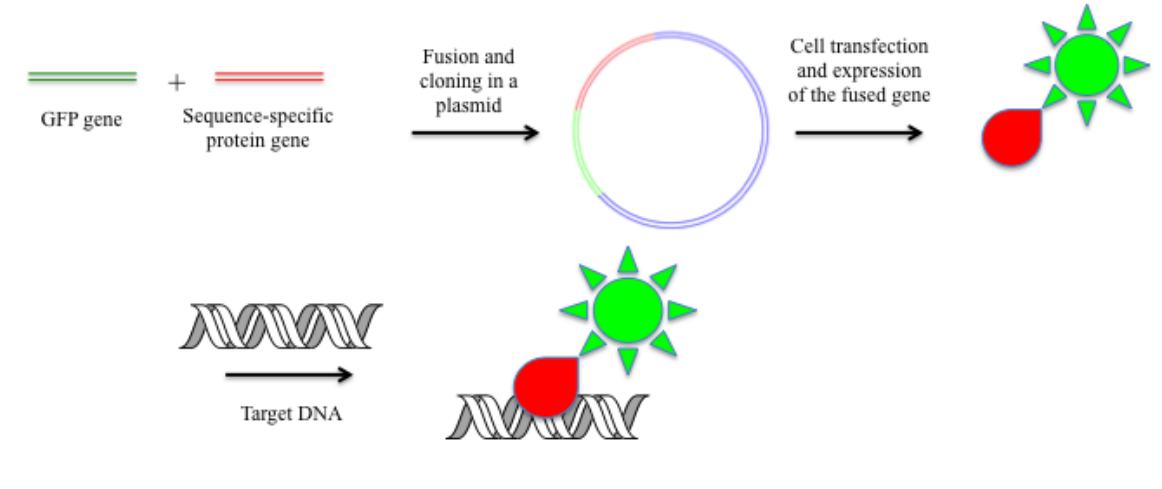
Figure 3. DNA imaging in living cells with fused proteins containing GFP and site-specific or sequence-specific